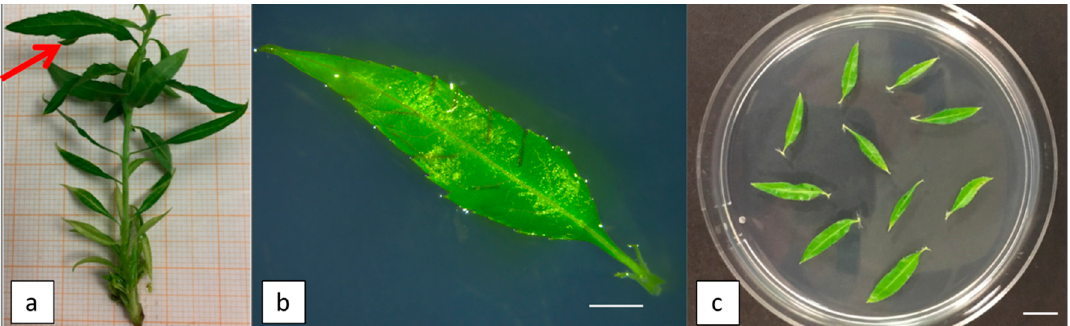
Figure 3. Plant material used as the starting explants in this study: ( a ) leaves collected from 3-week-old elongated shoots of Hansen 536. The arrow indicates the type of leaf collected and used in all the regeneration experiments; ( b ) the young leaf of the Hansen 536 wounded perpendicular to the mid vein and placed with the abaxial side on regeneration medium (bar = 2 mm), and ( c ) in vitro leaves of Hansen 536 placed on regeneration medium (bar = 1 cm).